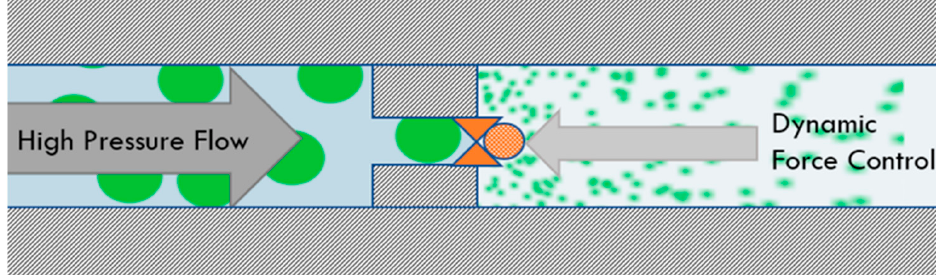
Figure 5. Schematic representation of the UST annular valve mechanism of action. The unprocessed product is forced through an annular gap between a ball and a seat of the homogenizer valve, while the ball is being actively pressed against the seat with a controlled force to maintain the minimal gap opening across a wide range of flow rates and material viscosity values. The valve gap is adjustable from 0–1000 nm.